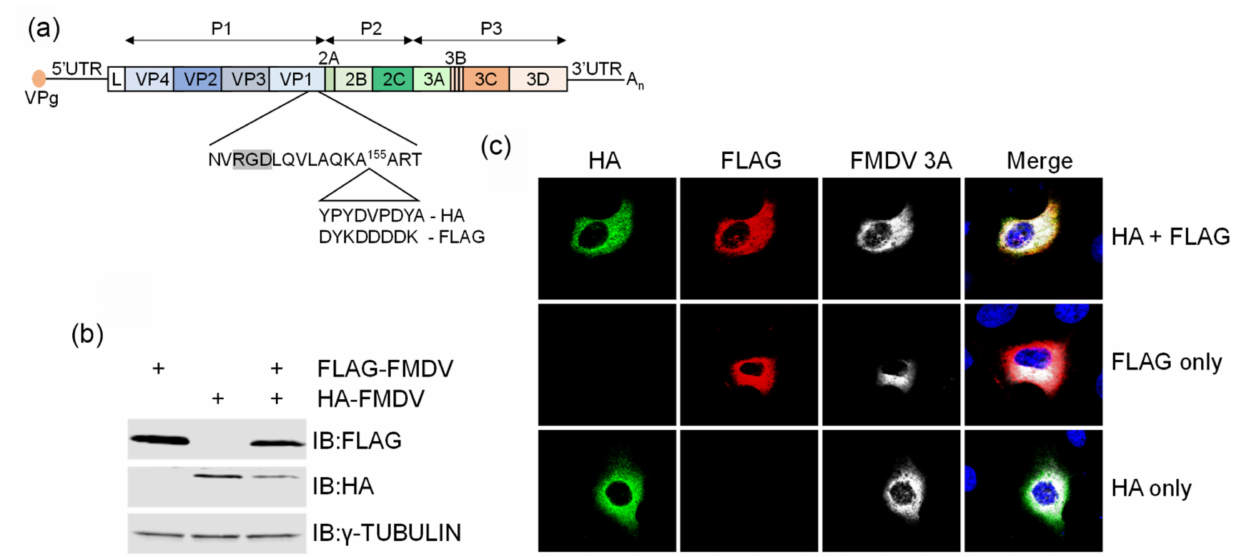
Figure 1. Co-infection of goat epithelium cells with HA- and FLAG-tagged FMDV O1K/O UKG35. ( a ) Schematic diagram showing the position of the tag insertion in the FMDV O1K/O UKG35 infectious clone. ( b ) Confluent monolayers of ZZ-R 127 cells were infected with FLAG-FMDV O1K/O UKG35 (MOI = 1), HA-FMDV O1K/O UKG35 (MOI = 1) or both (MOI = 0.5/virus) for 6 h. Epitope-tagged VP1 proteins in lysates from infected cells were detected by immunoblotting (IB) with antibodies to the FLAG and HA tags, and an anti- γ -tubulin antibody was used to demonstrate equal loading. ( c ) Immunofluorescence microscopy of cells infected with FLAG-FMDV O1K/O UKG35 (MOI = 1), HA-FMDV O1K/O UKG35 (MOI = 1) or both (MOI = 0.5/virus). Cells were stained with antibodies to the HA tag (AF 488-green), the FLAG tag (AF 568-red), FMDV 3A and 3A/3B precursors (AF 633-white) and nuclei were stained with DAPI